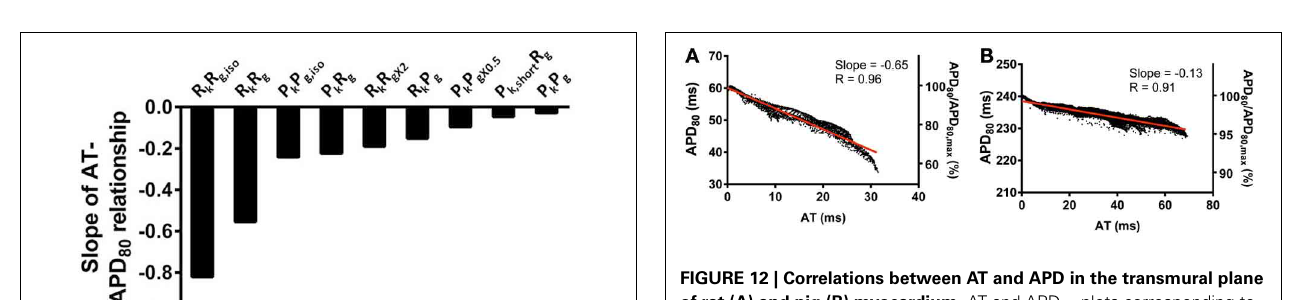
uniformly in all directions across the epicardial surface. A similar pattern of APD was observed in the pig simulations however the range of APD values were much smaller. The RT map was relatively homogeneous in the rat simulations compared to the pig (right panels). The RT pattern in pig closely followed the activation sequence. Isochrones are spaced 2 and 4ms apart for rat and pig, respectively.